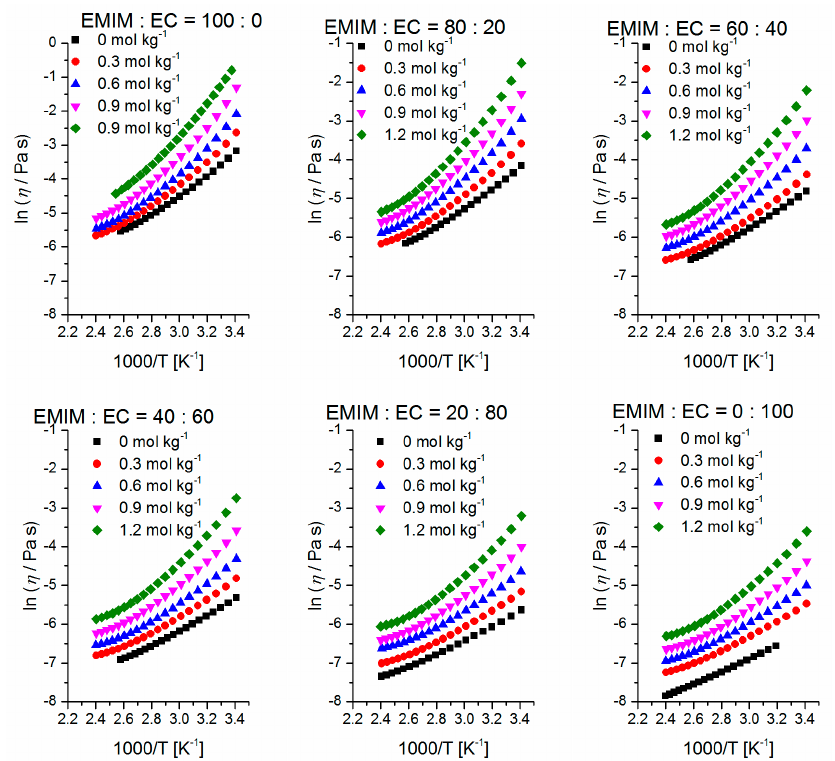
Figure 7. Temperature-dependent Arrhenius plots of the mixtures’ viscosity data in the temperature range of 20–120 °C. The measurements are performed on a 40 mm/1° cone with a heating rate of 3 K·min − 1 at shear rate of (cid:2011)(cid:4662) = 100 s − 1 . The concentration of Li-TFSA is mentioned between 0 and